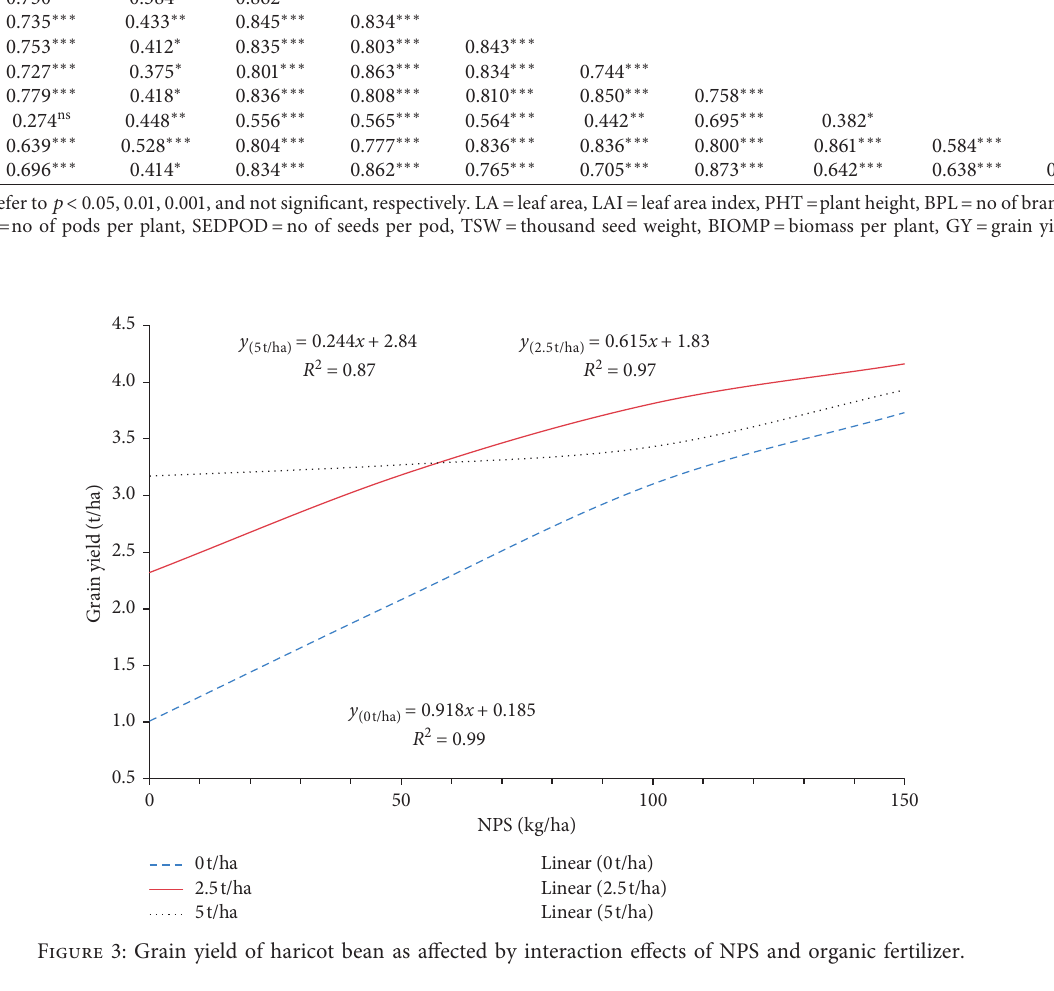
x 2 – 2600.7 x + 23806